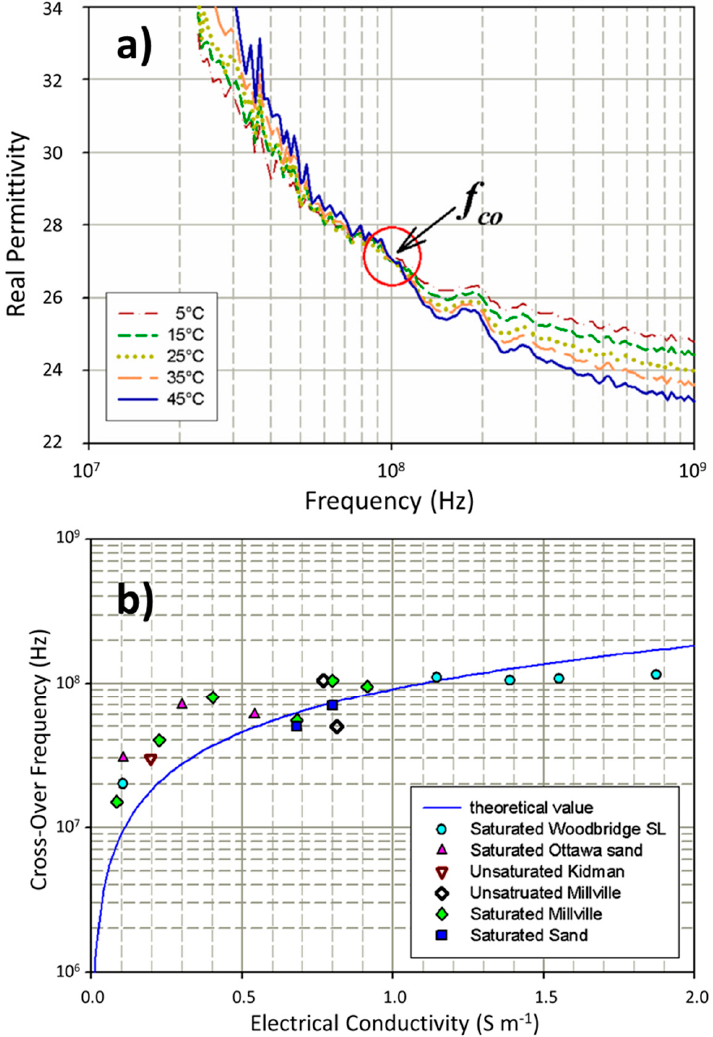
Figure 9. ( a ) Cross-over frequency illustrated in the frequency-dependent real permittivity spectra of Woodbridge silt loam at a water content of 0.15 m 3 m − 3 and solution electrical conductivity (EC) of 0.9 S/m measured at different temperatures (modified from Chen and Or [139] Figure 7b). ( b ) Cross-over frequencies determined as in ( a ) for different soils with the modeled values as functions of electrical conductivity of the bulk soil (modified from Chen and Or [139] Figure 9).